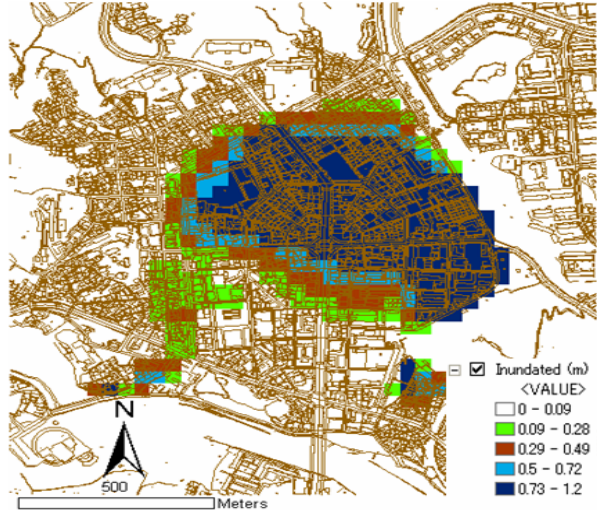
Fig. 9. Simulated results at maximum inundated depth on ArcMap